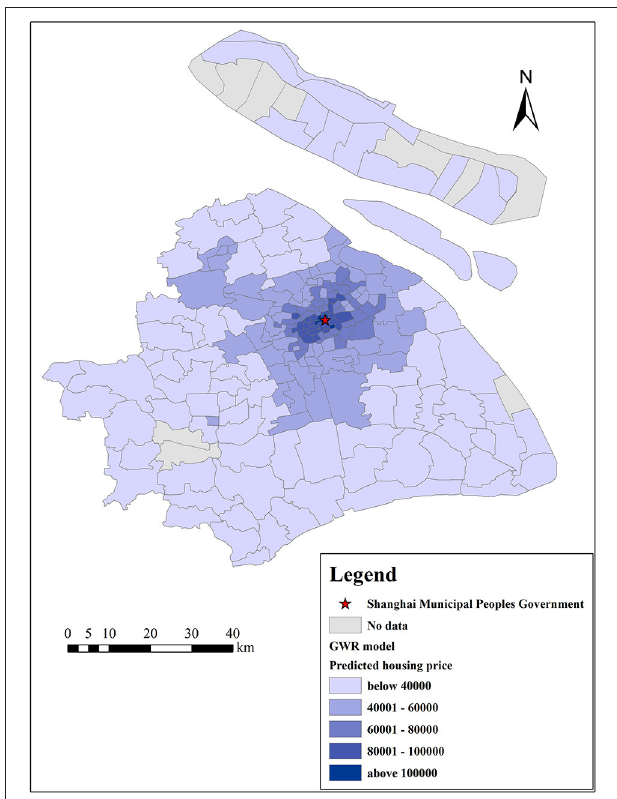
FIGURE 9 | Predicted housing prices (Yuan/m 2 ) in Shanghai based on the GWR model.